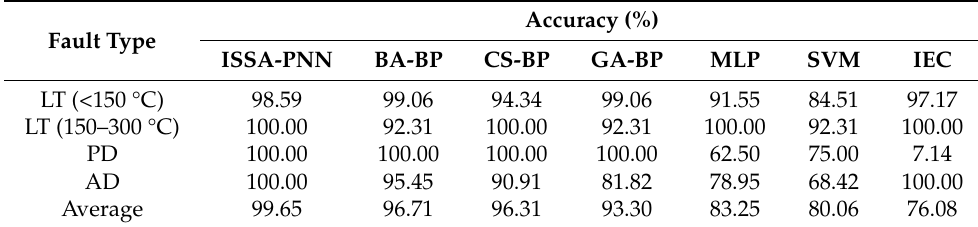
Table 7. Accuracy comparison of different